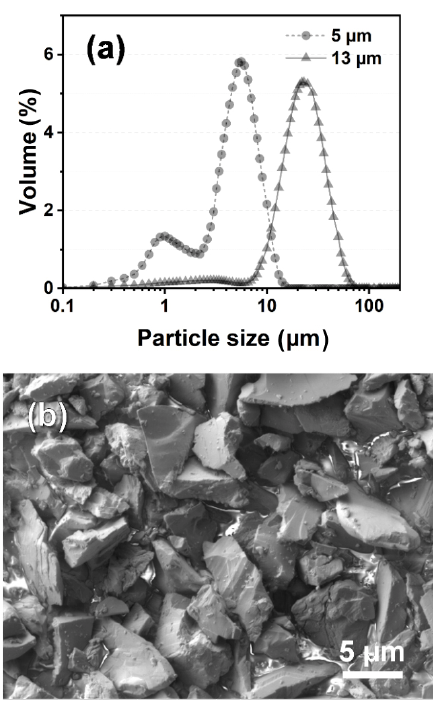
Fig. 1 Characterization of the particles in the slurry: (a) particle size distribution; (b) SEM image of alumina particles in the 5 µm slurry.